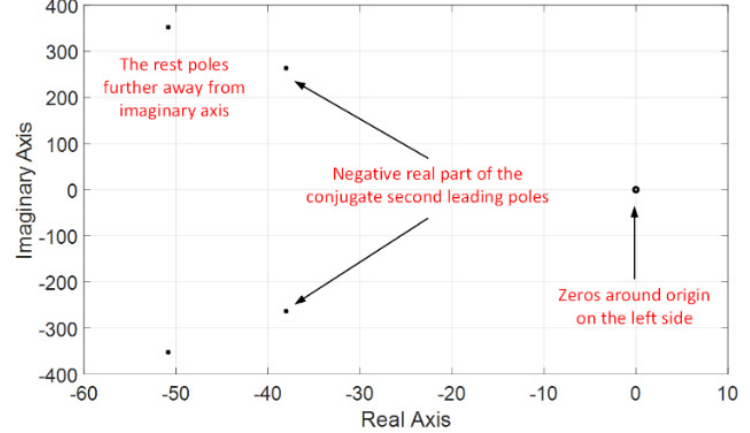
Figure 10. Pole zero map.